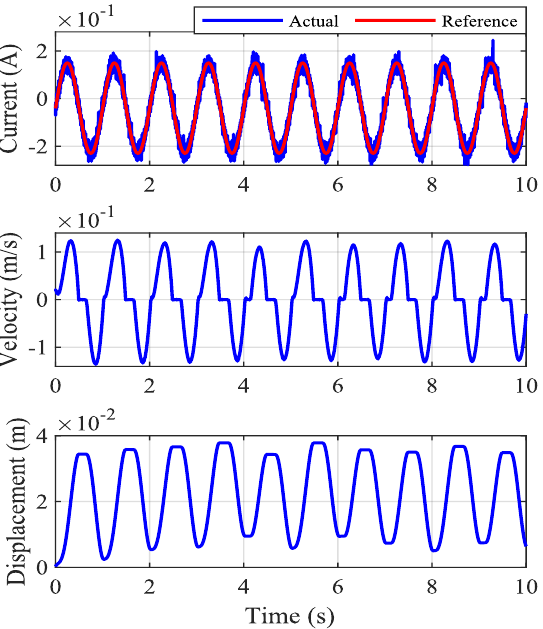
Figure 8. Experimental results of the open-loop response to a sinusoidal reference current/force at 1.0